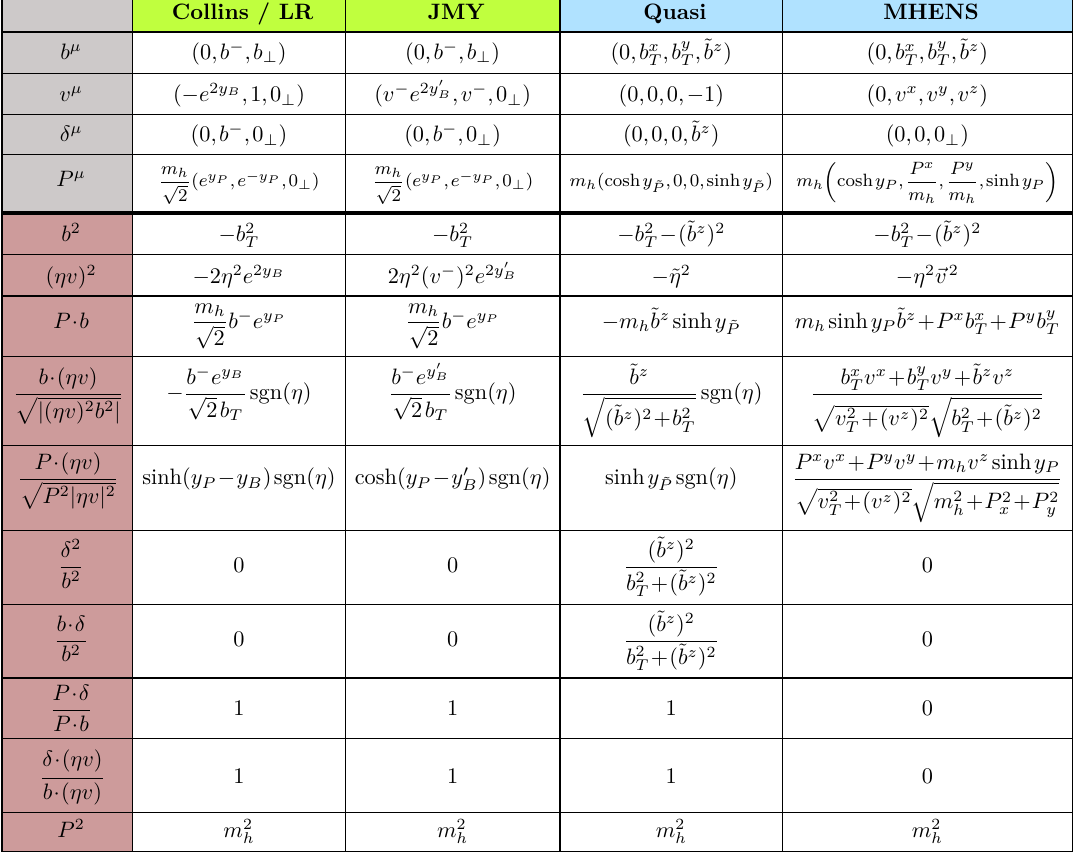
Table 2 . Overview of the Lorentz invariants entering the generic TMD correlator as specified by eq. (2.11). Note that the Collins and LR schemes use the same four-vectors. where the dimensionless form factors Ω on the right-hand side are functions of the 10 Lorentz invariants in eq. (2.11), which we suppress for brevity. The prefactors share the same mass p dimension and are finite as δ → 0 or b · v/ | v 2 b 2 | → 0 . In the second line, we neglect terms that are suppressed at large momentum P , which do not contribute at leading